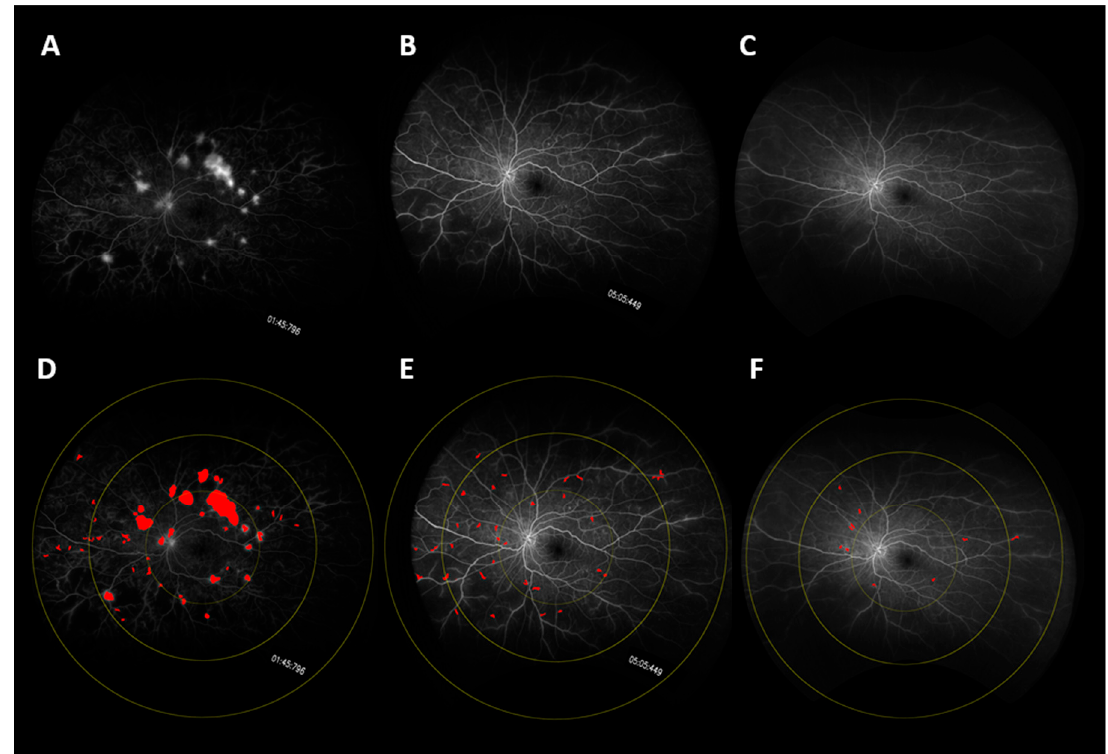
Figure 1. UWFA fundus images of a representative case showing changes in leakage over time. Fundus images are shown at ( A ) Baseline, ( B ) Year 1, ( C ) Year 3. Leakage mask over-lays are shown at ( D ) Baseline, ( E ) Year 1, and ( F ) Year 2. Figures D, E, F also show the macula-centered concentric rings: Zone 1 defines a posterior zone with a 3-disc-diameter boundary including the fovea. Zone 2 defines a mid-periphery zone with a 6-disc-diameter boundary centered at the fovea. Zone 3 defines a far periphery zone with a 9-disc-diameter boundary centered at the fovea.